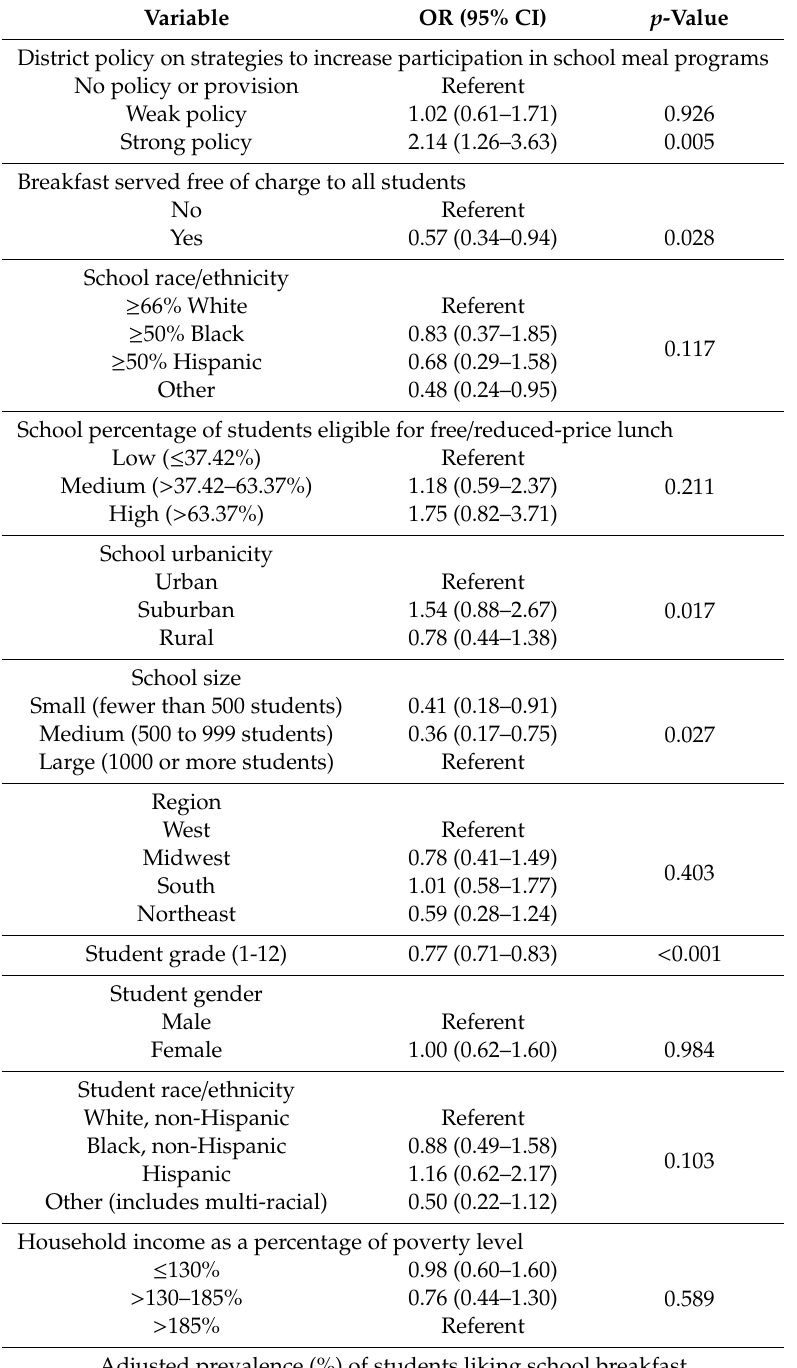
Table 3. Logistic regression results for the association between district policy on strategies to increase participation in school meal programs and students’ liking of school breakfast ( n = 726